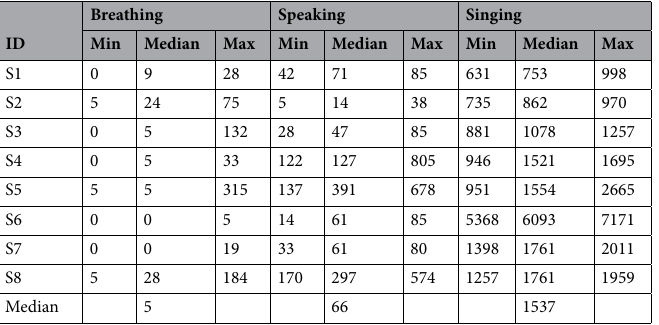
Table 1. Minimum, maximum, and median values of emission rates in particles/sec for breathing, speaking, and singing based on five test replications per test condition (cumulative values for all size classes > 0.3 µm).